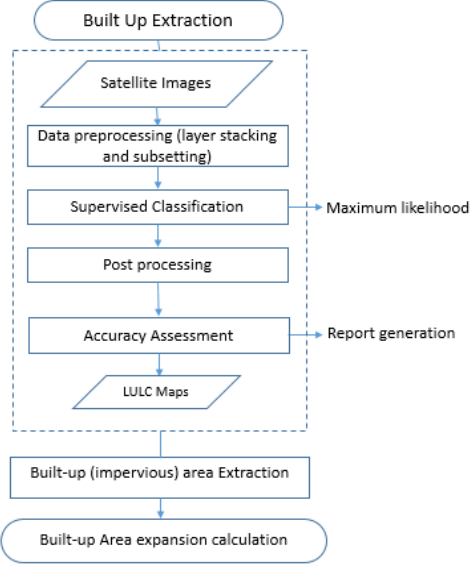
Figure 10. Methodology to Map extent of Urbanization